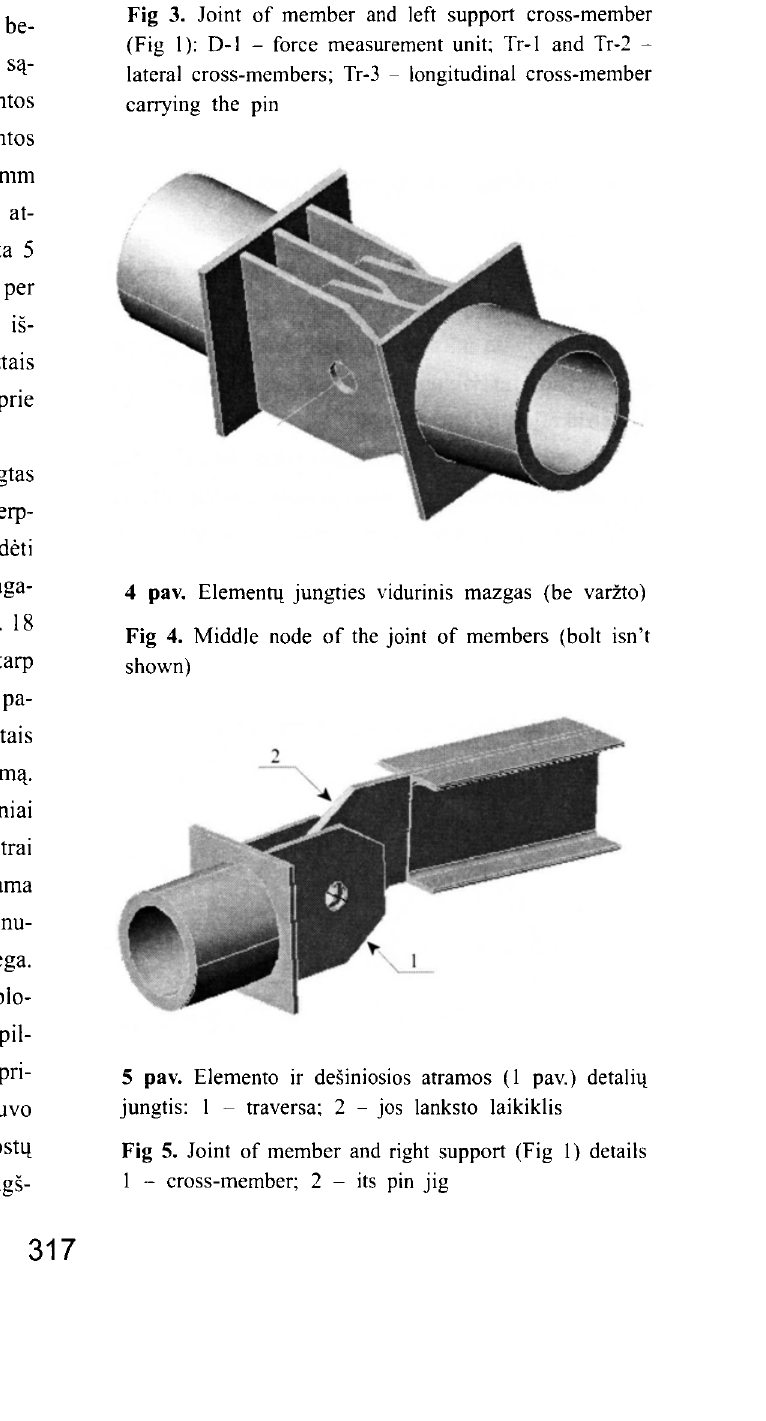
3 pav. Elemento ir kairiosios atramos (I pav.) traversos jungtis: D-1 - dinamometras: Tr-1 ir Tr-2 - skersines traversos: Tr-3 - isilgine lankstii laikanti traversa Fig 3. Joint of member and left support cross-member (Fig I): D-1 - force measurement unit; Tr-1 and Tr-2 - lateral cross-members; Tr-3 - longitudinal cross-member carrying the pin